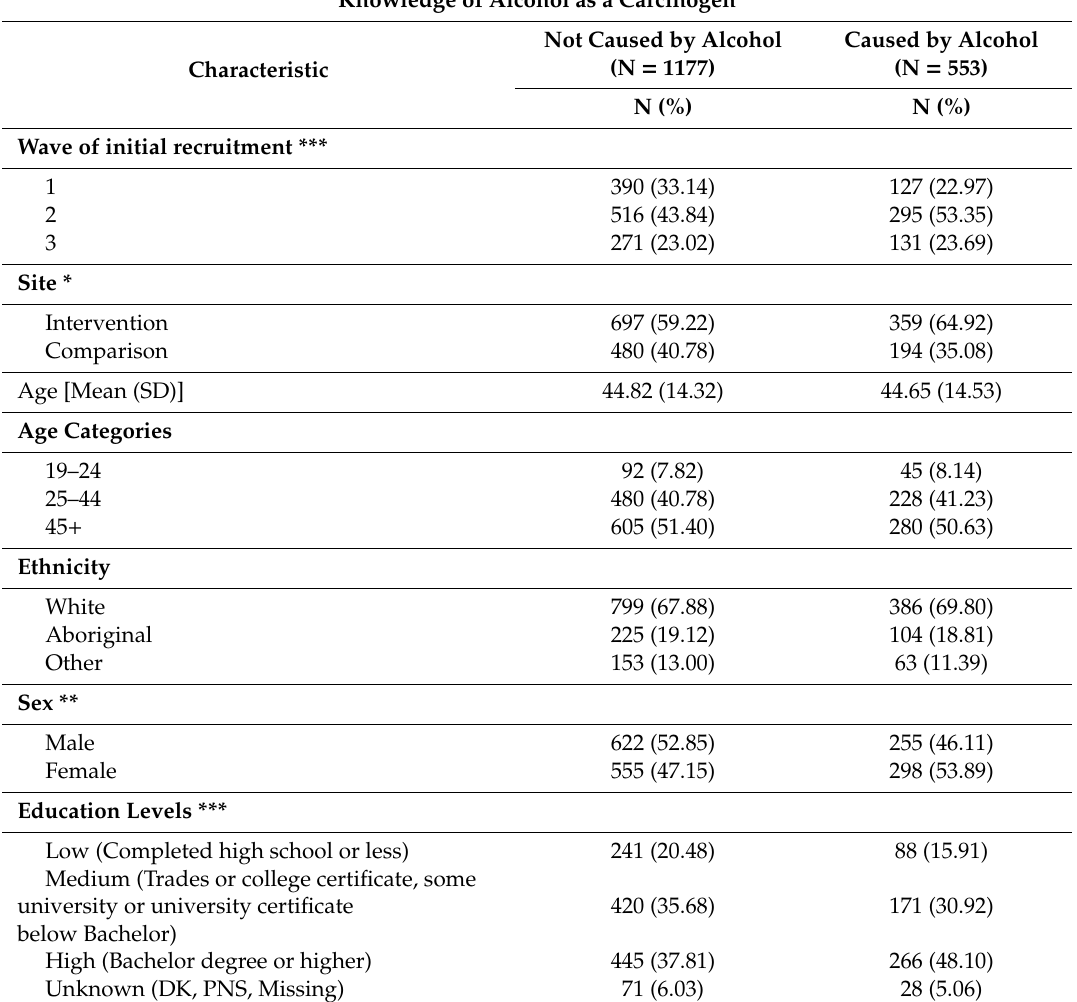
Table 1. Sample characteristics by Knowledge of Alcohol-Cancer Link at time of initial recruitment (n =